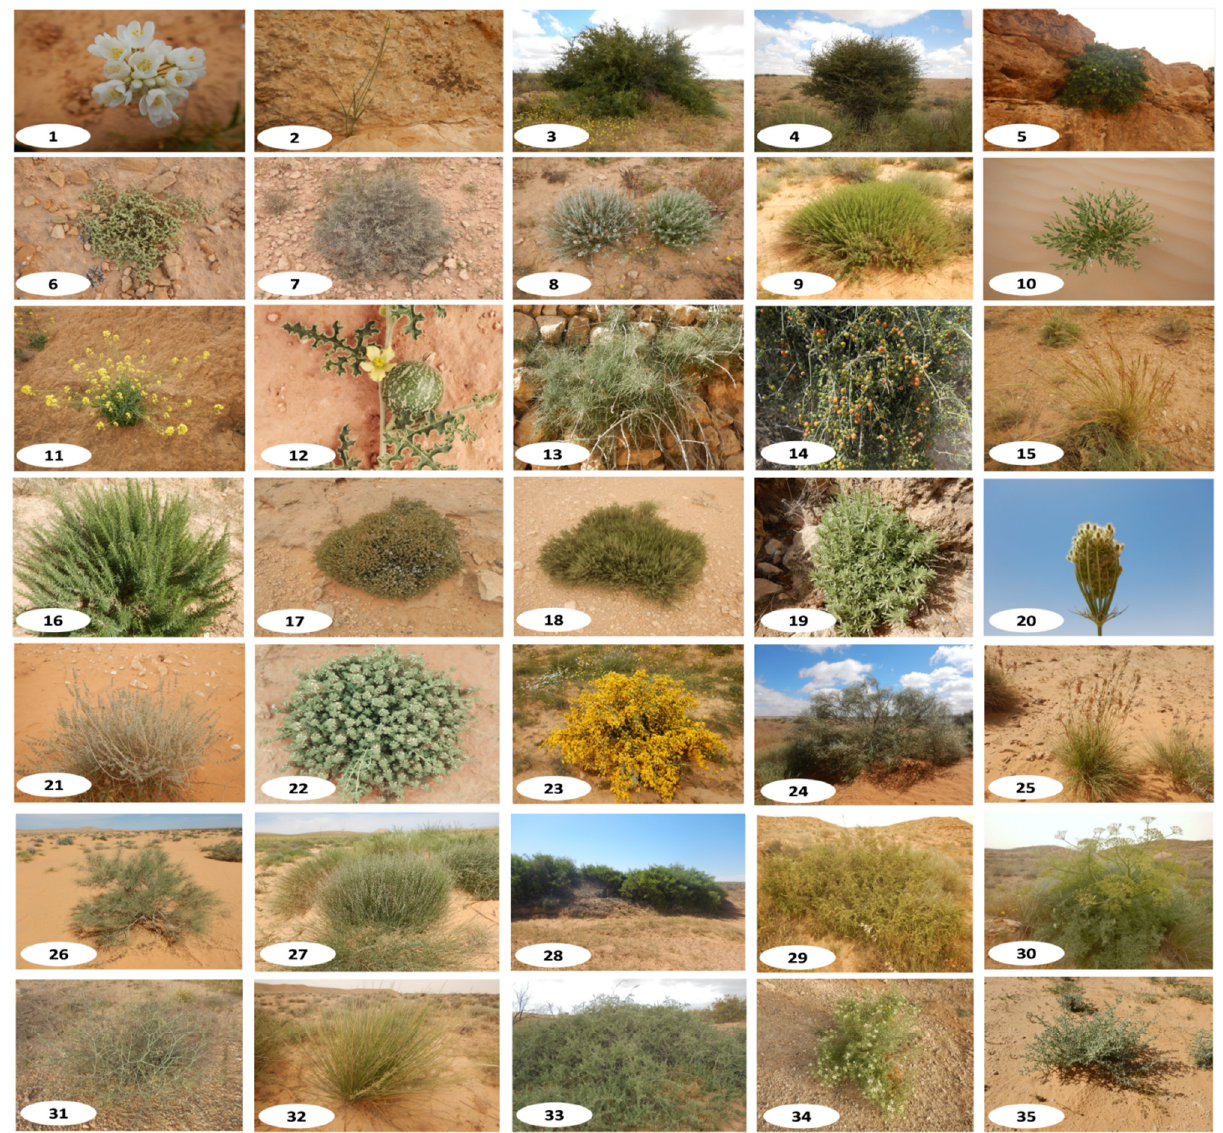
Figure 8. Medicinal and aromatic plants recorded in the arid and desert rangelands of Tataouine, Tunisia (spring 2018) (Photos by Mouldi Gamoun).